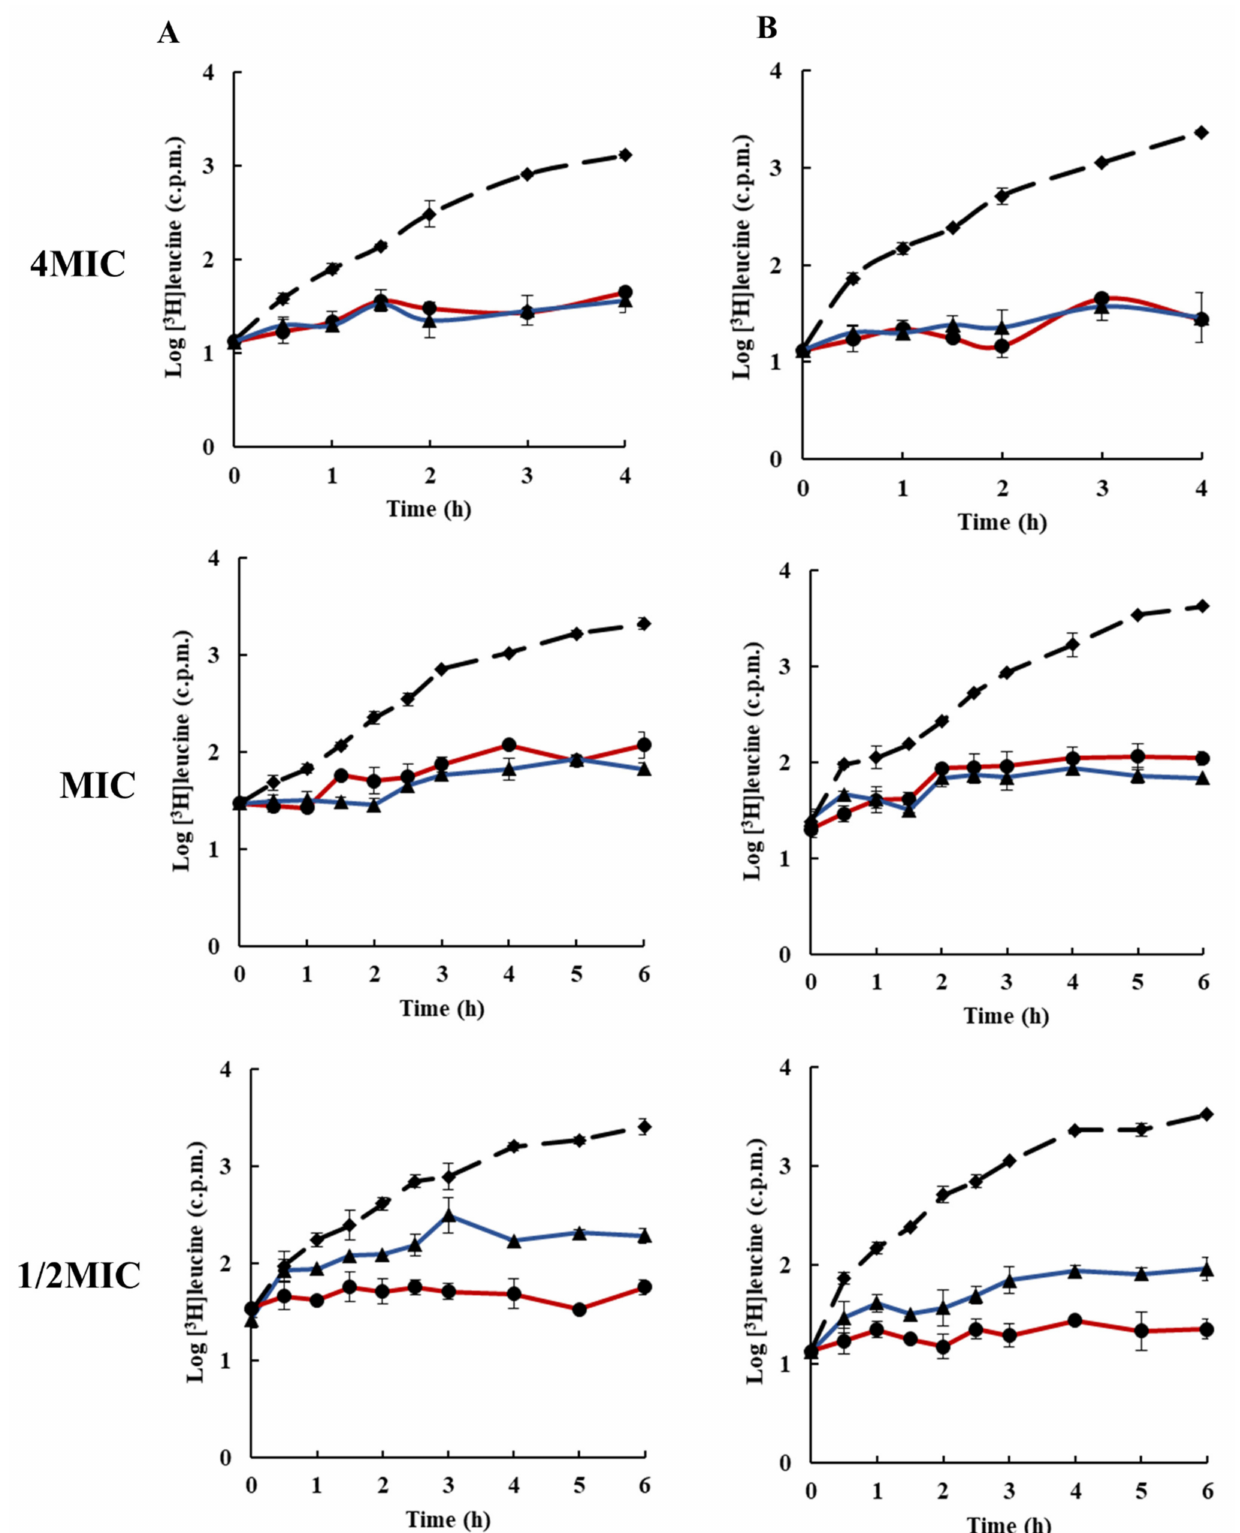
Figure 4. Effects of rhodomyrtone on protein synthesis at 4 × MIC, MIC, and 1/2 × MIC on ( A ) EMRSA-16 and ( B ) S. aureus Figure 5. Effects of rhodomyrtone on cell wall synthesis at 4× MIC, MIC, and 1/2× MIC on ( A ) EMRSA-16 and ( B ) S. aureus ATCC 29213. Protein synthesis, determined by incorporation of [ 3 H]leucine, rhodomyrtone (blue (cid:78) ),chloramphenicol ATCC 29213. Cell wall synthesis was determined by incorporation of N-acetyl-d-[1- 3 H]glucosamine. rhodomyrtone (blue ▲ ), (red • ), and 1% DMSO (broken line vancomycin (red ● ), and 1% DMSO (broken line  ). Each symbol indicates the mean ± SD for duplicates. ). Each symbol indicates the mean ± SD for